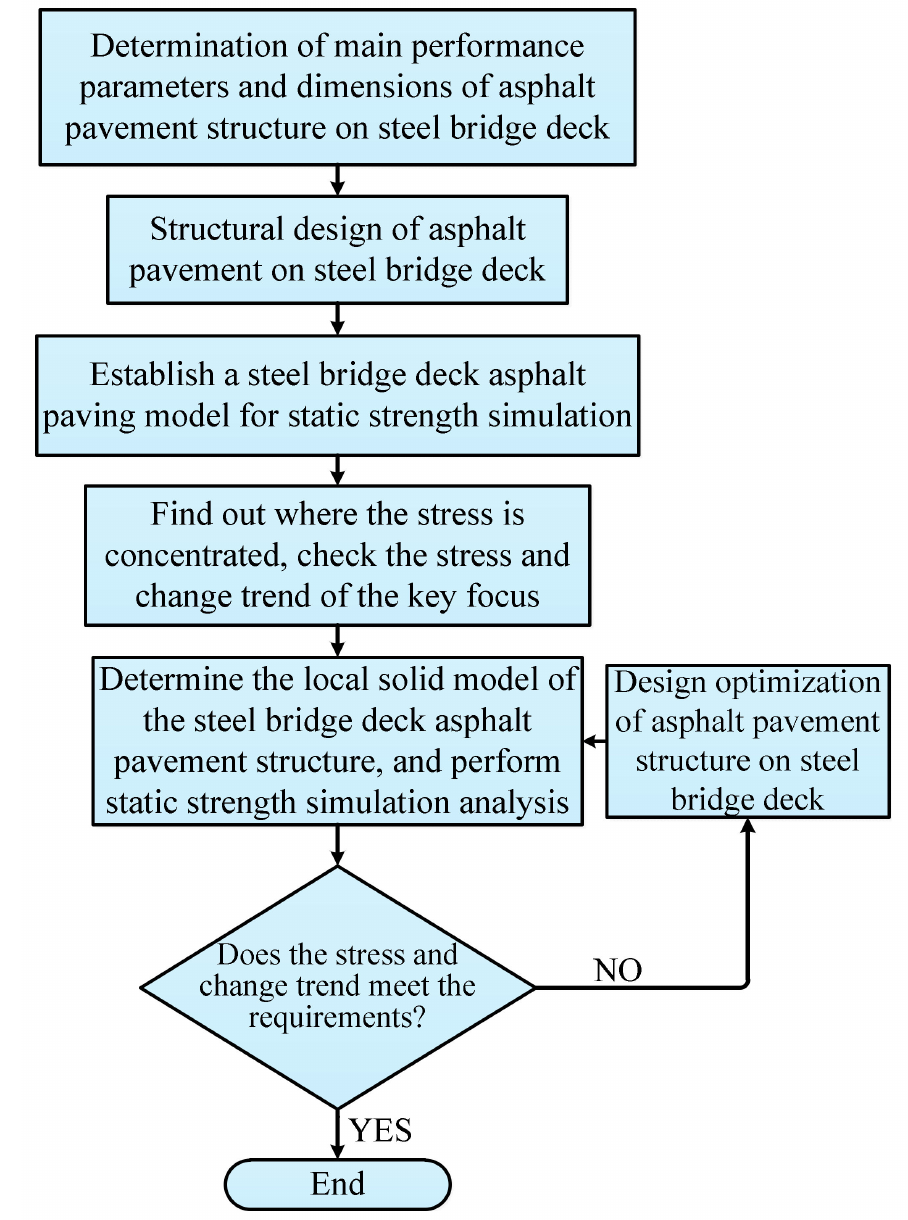
Figure 2. Design strategy flow of asphalt pavement structure on the steel bridge deck. (1) Establish a local solid model for the asphalt pavement on the steel bridge